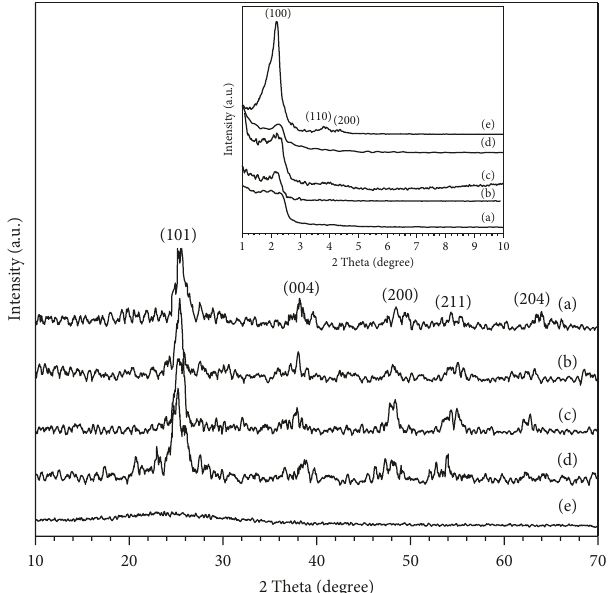
Figure 1: XRD patterns of (a) Al-MCM-41@0 15Ag/TiO MCM-41@0 1Ag/TiO 2 , (c) Al-MCM-41@0 05Ag/TiO 2 , (d) Al- MCM-41@TiO 2 , and (e) Al-MCM-41. Inset is the small angle X-ray diffraction